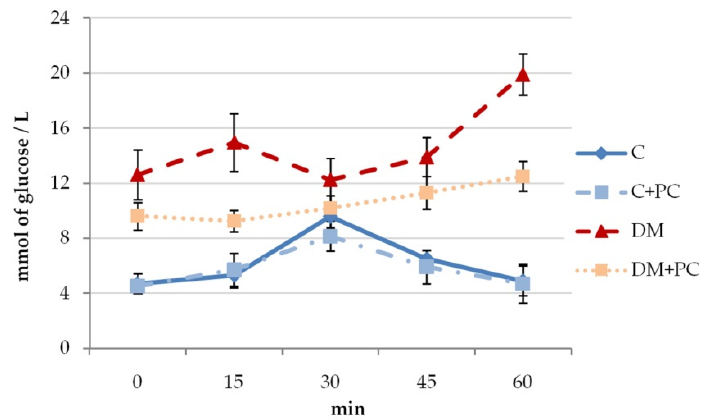
Figure 1. Glucose tolerance test of control and diabetic rats, with and without PC concentrate. C–normal untreated control animals; C + PC–animals that were per os administrated PC concentrate (daily dose of 45 mg/kg bw of polyphenolic complex for 14 days); DM–rats with experimental diabetes mellitus; DM + PC–animals with experimental diabetes mellitus that were per os administrated PC concentrate (daily dose of 45 mg/kg bw of polyphenolic complex for 14 days).